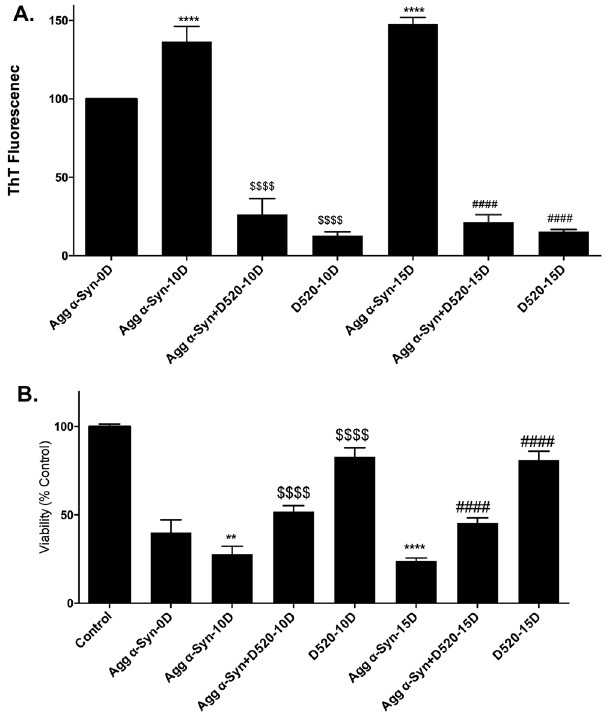
Figure 2. Effect of D-520 on disaggregation of α -synuclein aggregates formed by seeding: ( A ) Aggregates formed by incubating 1.25 mg/mL α -syn with 0.5% PFFs for a period of 30D without shaking were incubated with D-520 for a period of 15 days. The ability of D-520 to dissociate the aggregates was studied by ThT assay at 10D and 15D of incubation. Values are represented in terms of % 0D aggregated synuclein which represents the aggregates collected at 30D from seeding. ( B ) Viability of PC12 cells was measured by MTT assay after 24 h treatment with aggregated synuclein incubated with D-520 collected at 10D and 15D. Values were normalized to control. Data values shown are means ± SD of three independent experiments. One-way ANOVA analysis followed by Tukey’s multiple comparison post hoc test was performed, **** p < 0.0001 and ** p < 0.01 compared to aggregated Syn-0D,; $$$$ p ≤ 0.0001 compared to aggregated synuclein-10D and #### p ≤ 0.0001 compared to aggregated